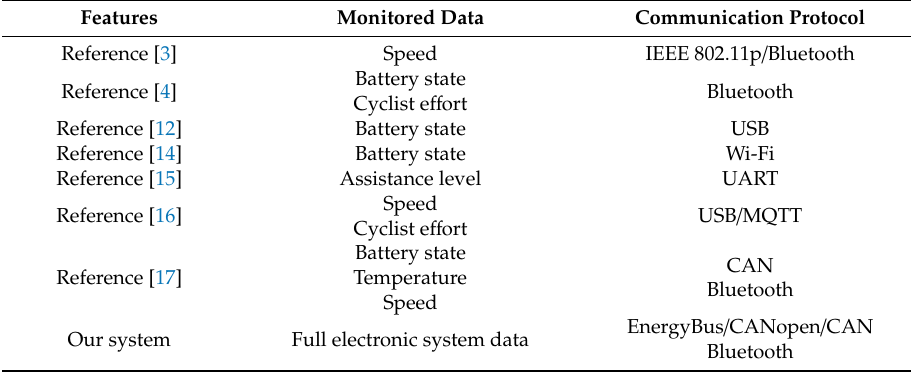
Table 1. Comparison of prior works for e-bike monitoring applications and our